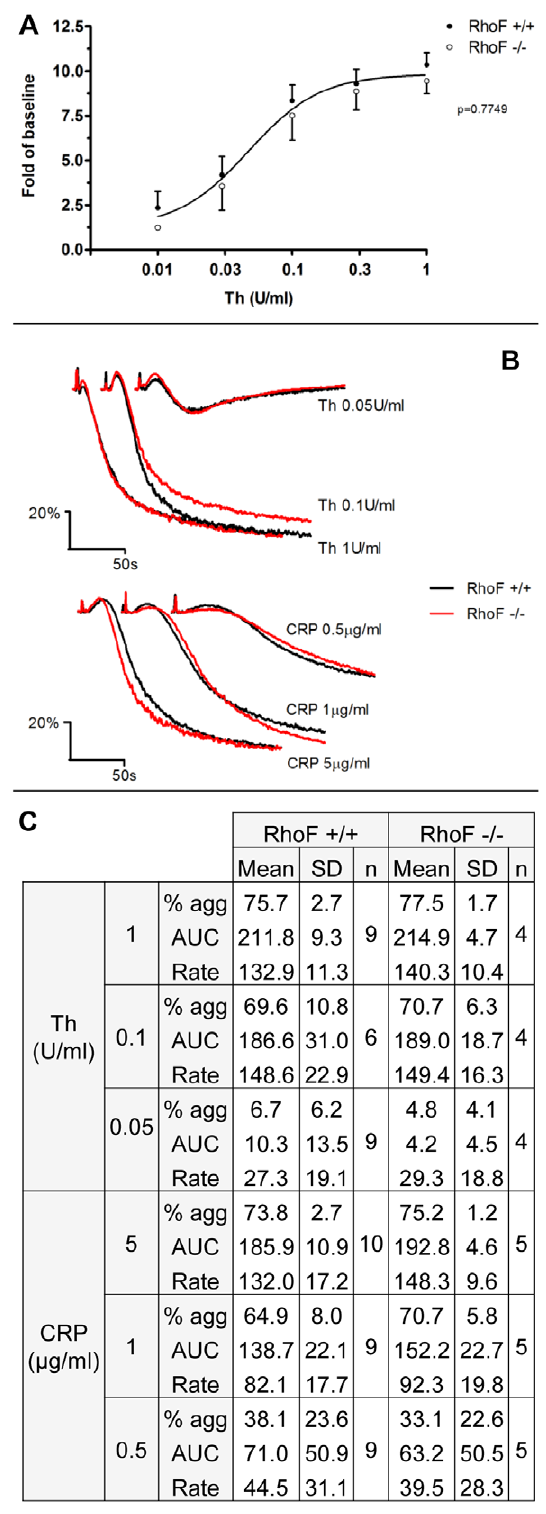
Figure 4. Integrin activation and light transmission aggrego- metry of RhoF 2 / 2 platelets is normal in response to thrombin and CRP. ( A ) Dose-response curves for activation of integrin a IIb b 3 in response to thrombin stimulation as indicated by binding of the activation state specific antibody JON/A. No significant differences were identified between the fitted curves of wild-type and RhoF 2 / 2 platelets, suggesting that inside-out signalling to the integrin downstream